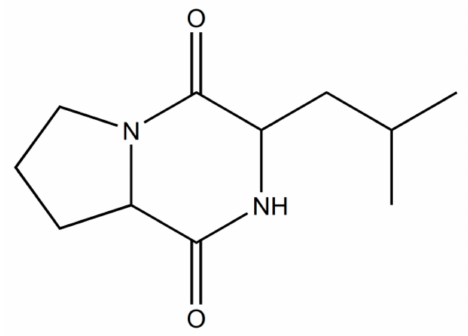
Figure 3. Chemical structure of the compound pyrrolo[1–a]pyrazine-1,4-dione,hexahydro-3- (2-methylpropyl).